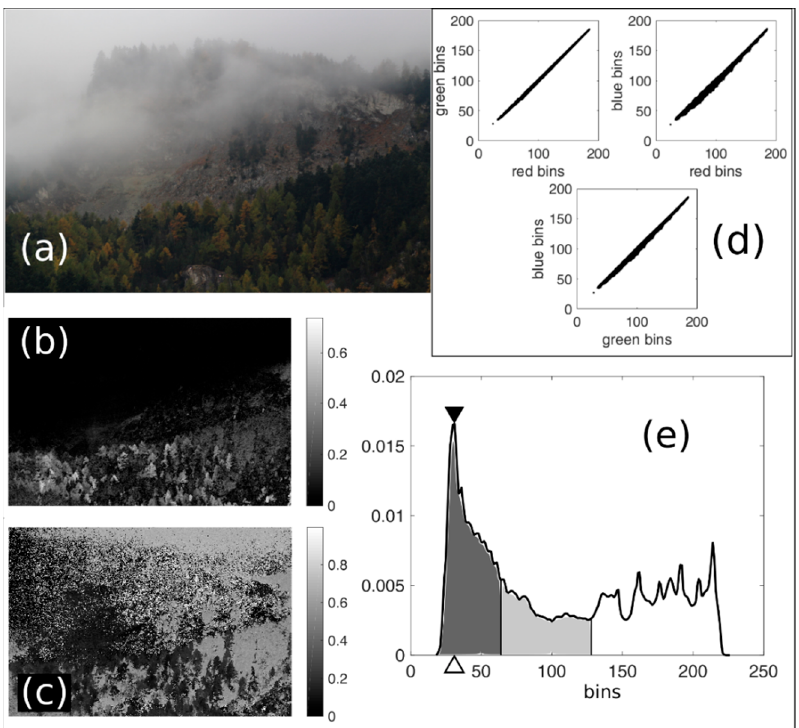
Figure 1. ( a ) Original 8-bit trichromatic (RGB) image of NoVis class; ( b ) saturation map; ( c ) hue map; ( d ) 8-bit RGB values, and ( e ) intensity histogram in which the ordinate value of the black triangle indicates the maxPeaks and the abscissa value of the white triangle represents posPeaks features. The dark and light grey areas are blackNum and greyNum features, respectively.